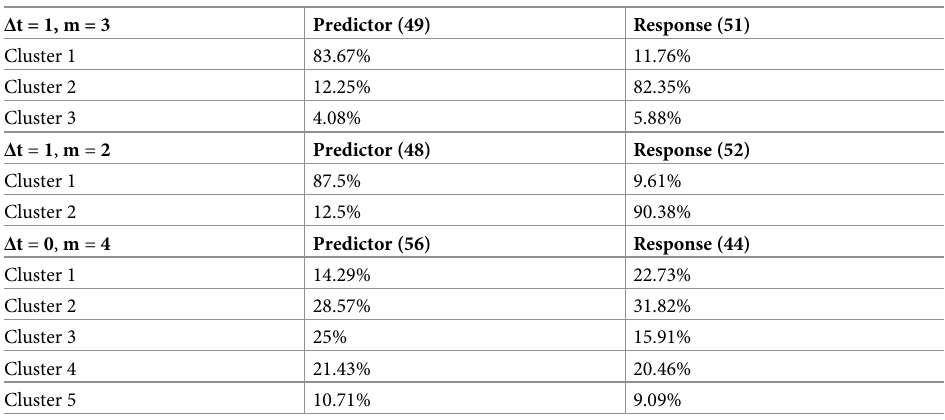
Table 3. Cluster identification.